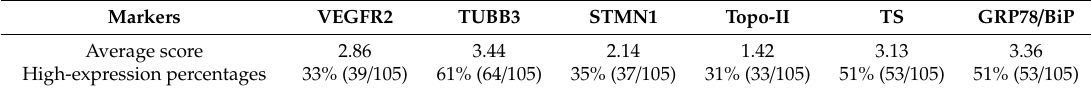
Table 1. The percentages based on di ff erential expression of the target markers.